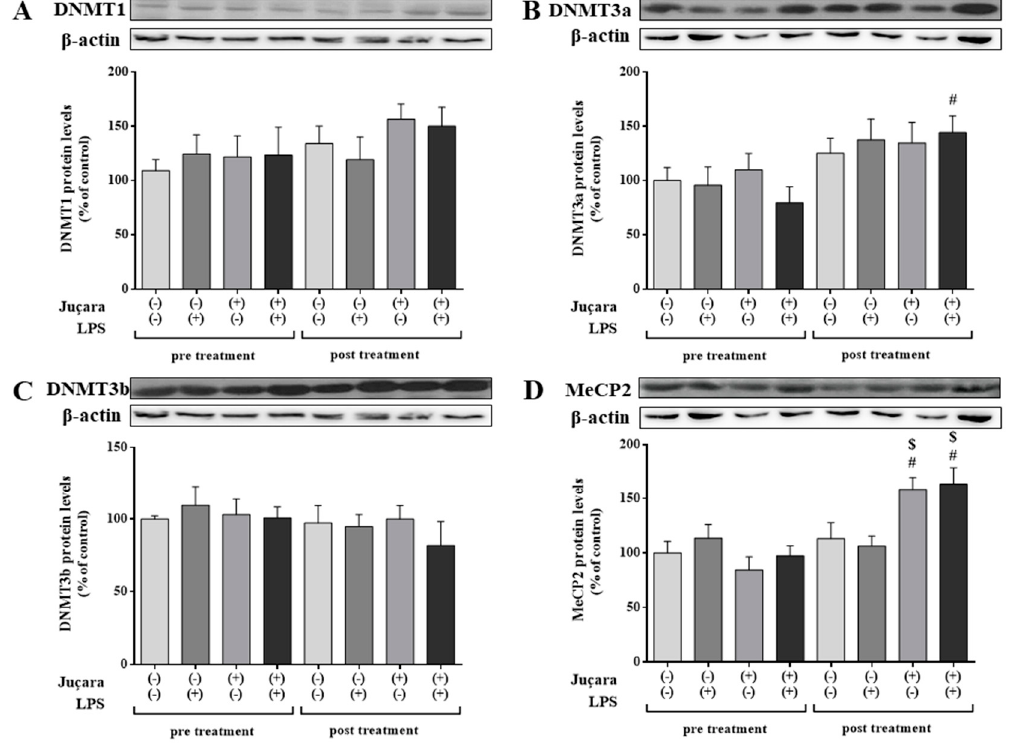
Figure 2. Monocyte epigenetic markers protein expression among groups before and after supplementation: ( A ) DNMT1; ( B ) DNMT3a; ( C ) DNMT3b; ( D ) MeCP2. The housekeeping used for all analyses was β -actin protein expression. # baseline versus post-treatment; $ placebo versus juçara group. (n = 10 per group)